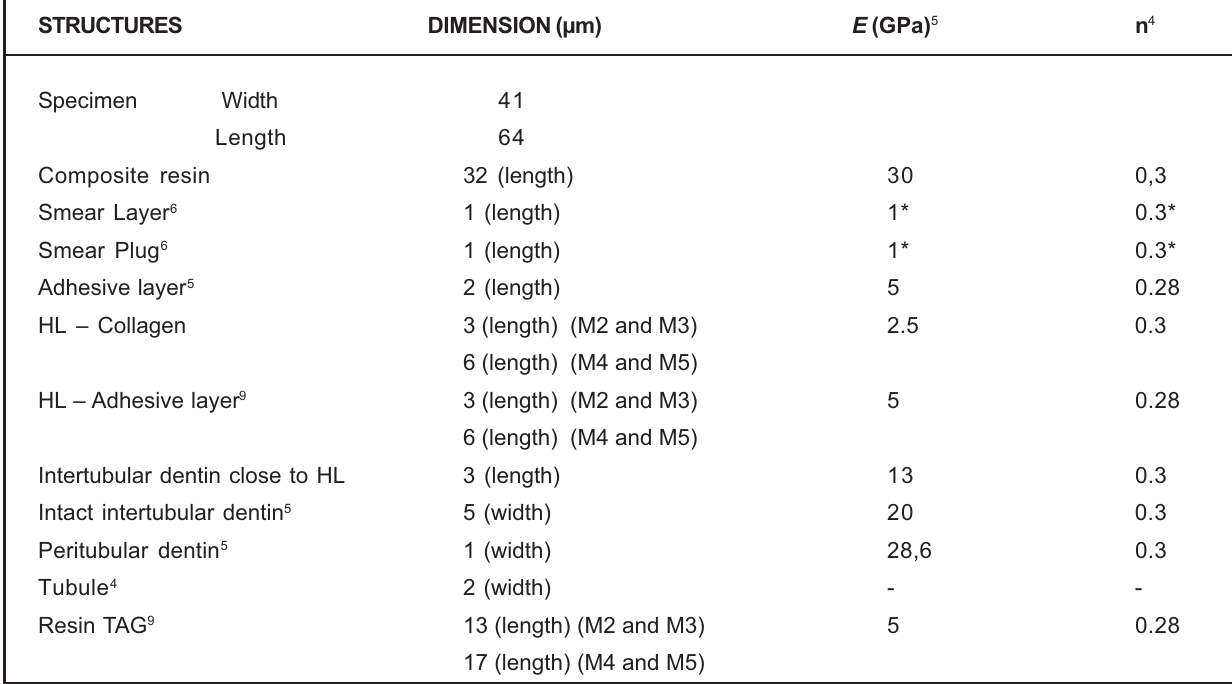
FIGURE 3- Dimensions (in µm) and material properties ( E and n